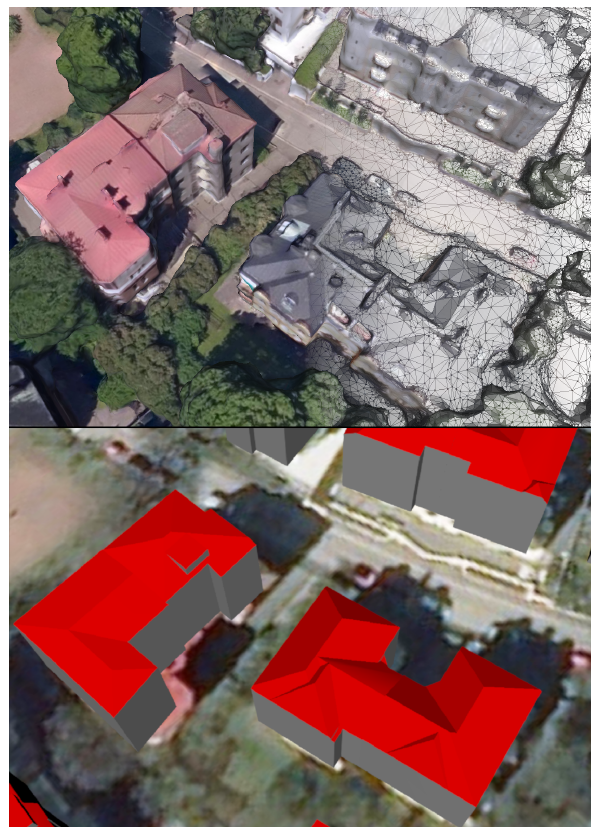
Figure 1. Snapshot of a residential area in Helsinki. The geometric structure (triangle mesh) of the 3D mesh model can be observed top right, while the textured mesh is displayed top left. The bottom image shows the same scene in the semantic 3D city model in CityGML LoD2 with surfaces colored according to their thematic classes